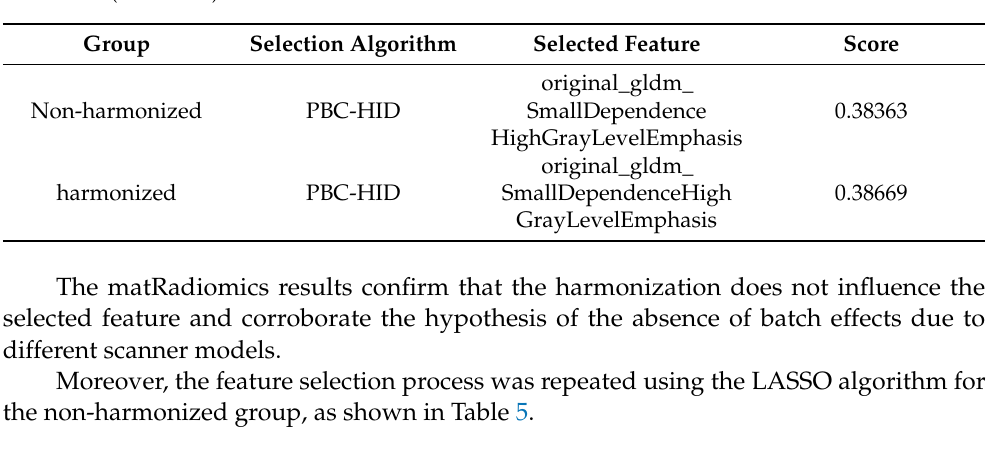
Table 4. Results of the feature selection step using the point biserial correlation-hybrid-descriptive inferential